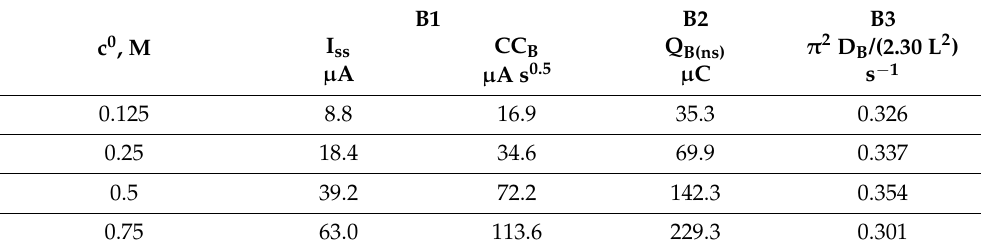
Table 1. Results of various procedures, B1 to B3, for treatment of experimental current transients of the Br − oxidation (Figure 4a).